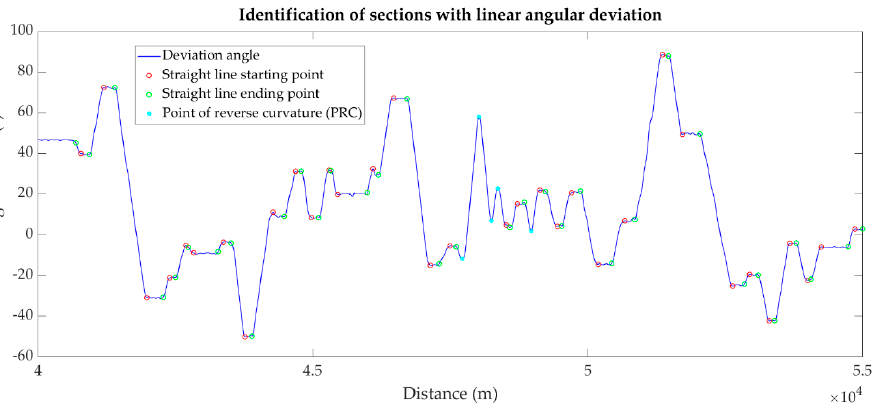
Figure 9. Identification of straight line starting and ending points and points of reverse curvature of the HWY 4—from the distance 40 km to the distance 55 km.